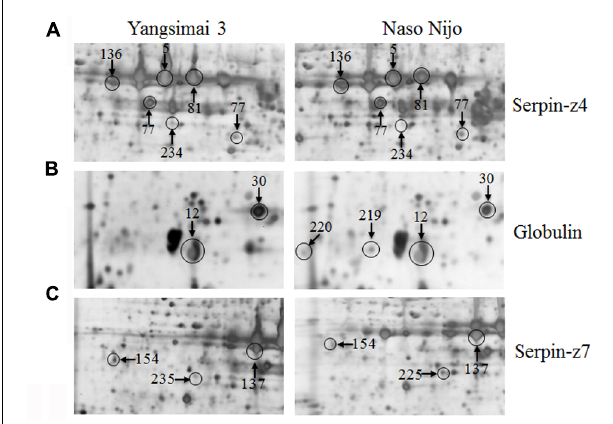
FIGURE 4 | Protein isoforms were observed on 2-DE gels. Serpin-Z4 (A) , Globulin (B) , and Serpin-Z7 (C) isoforms which were observed on Yangsimai 3 and Naso Nijo 2-DE